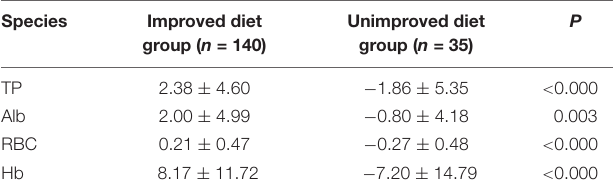
TABLE 6 | Comparison of nutritional status difference between the two groups after 1 year.